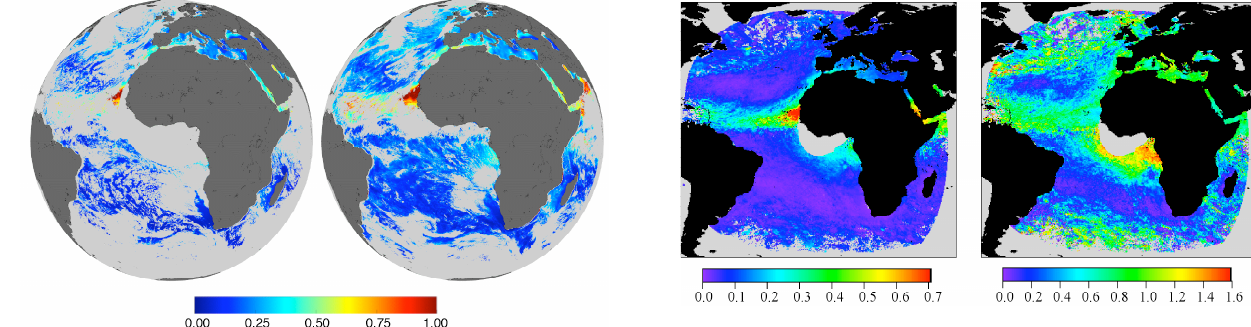
Fig. 1. Impact on the spatial coverage of the number of slots used to compute the daily aerosol optical thickness at 0.55 µ m for 7 June 2003 (METEOSAT-7 images). The left map has been computed with one single slot (12:15 UT), whereas the right map has been computed using nine slots (from 8:15 to 16:15 UT by step of 1). Continents are in dark grey, whereas masked marine pixels (either cloudy or contaminated by the Sun-glint) are grey.